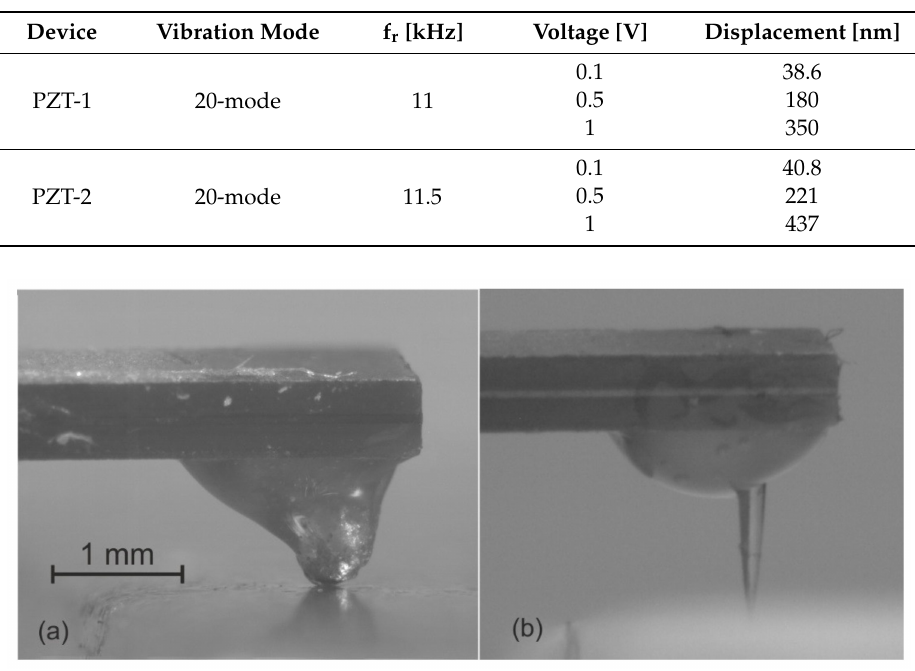
Figure 2. Picture of the di ff erent tips fixed to the PZT actuator. ( a ) PZT-1 actuator: aluminium tip; ( b ) PZT-2 actuator: tungsten